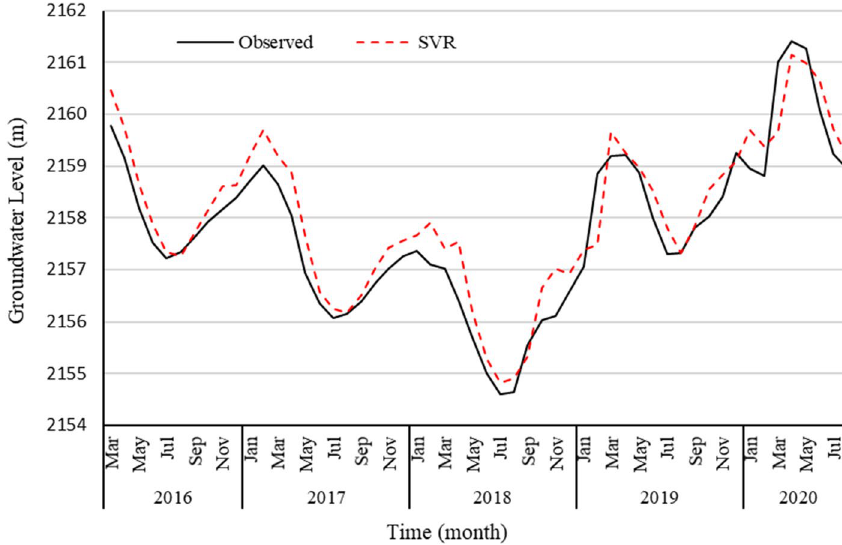
Fig. 8 Comparison of the SVR model with observed data